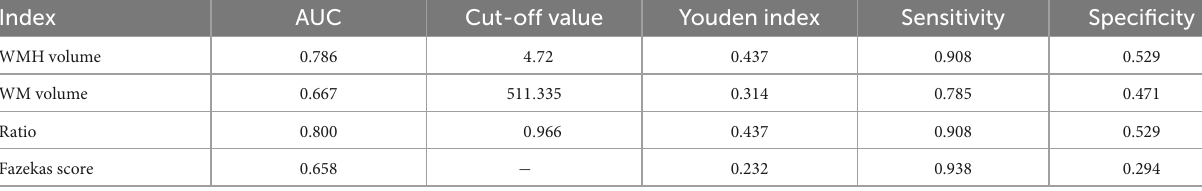
TABLE 6 Receiver operating characteristic (ROC) curve